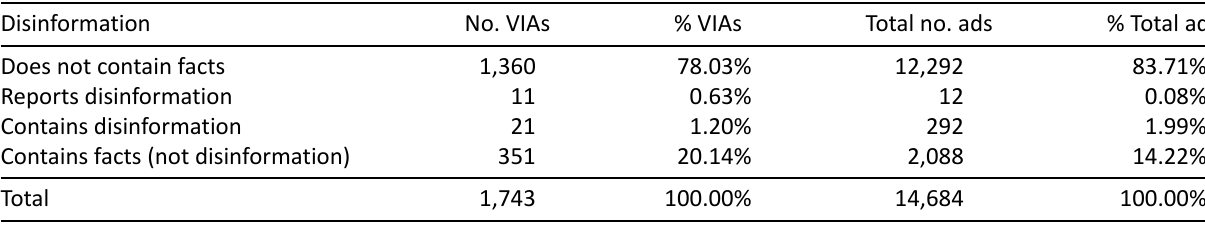
Table 2. Overall results of the disinformation analysis.